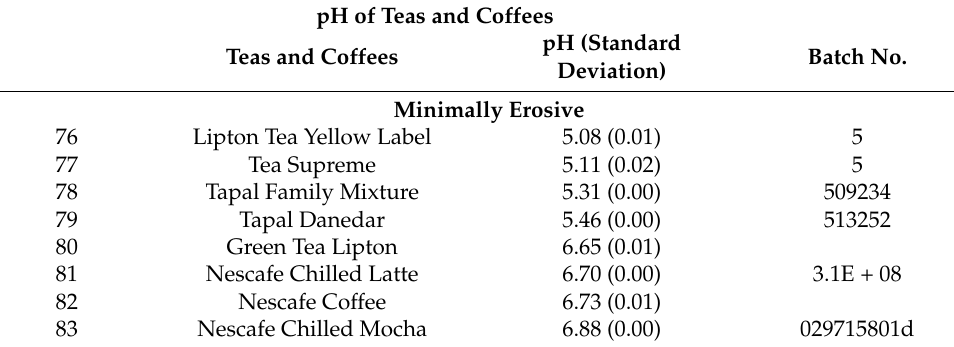
Table 5. pH (mean and standard deviation) of teas and coffees.